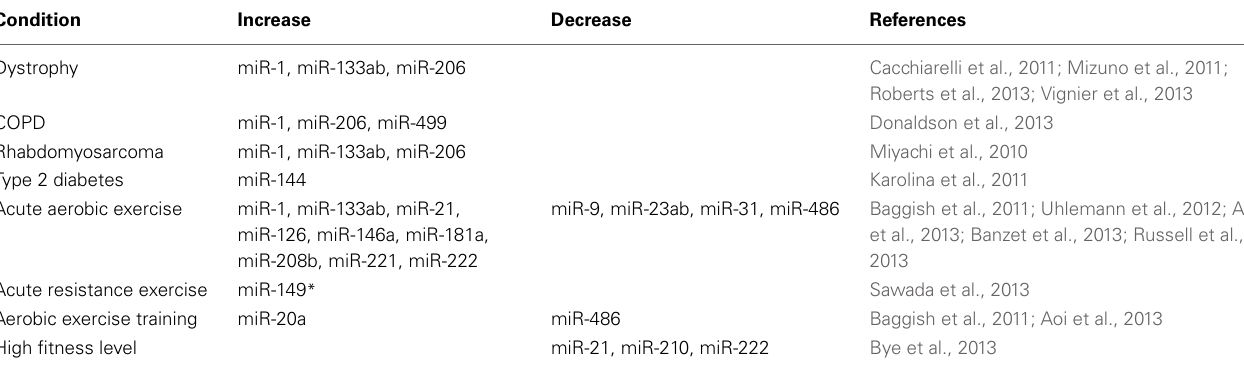
Table 1 | Change of circulating microRNAs in muscular physiological and pathological